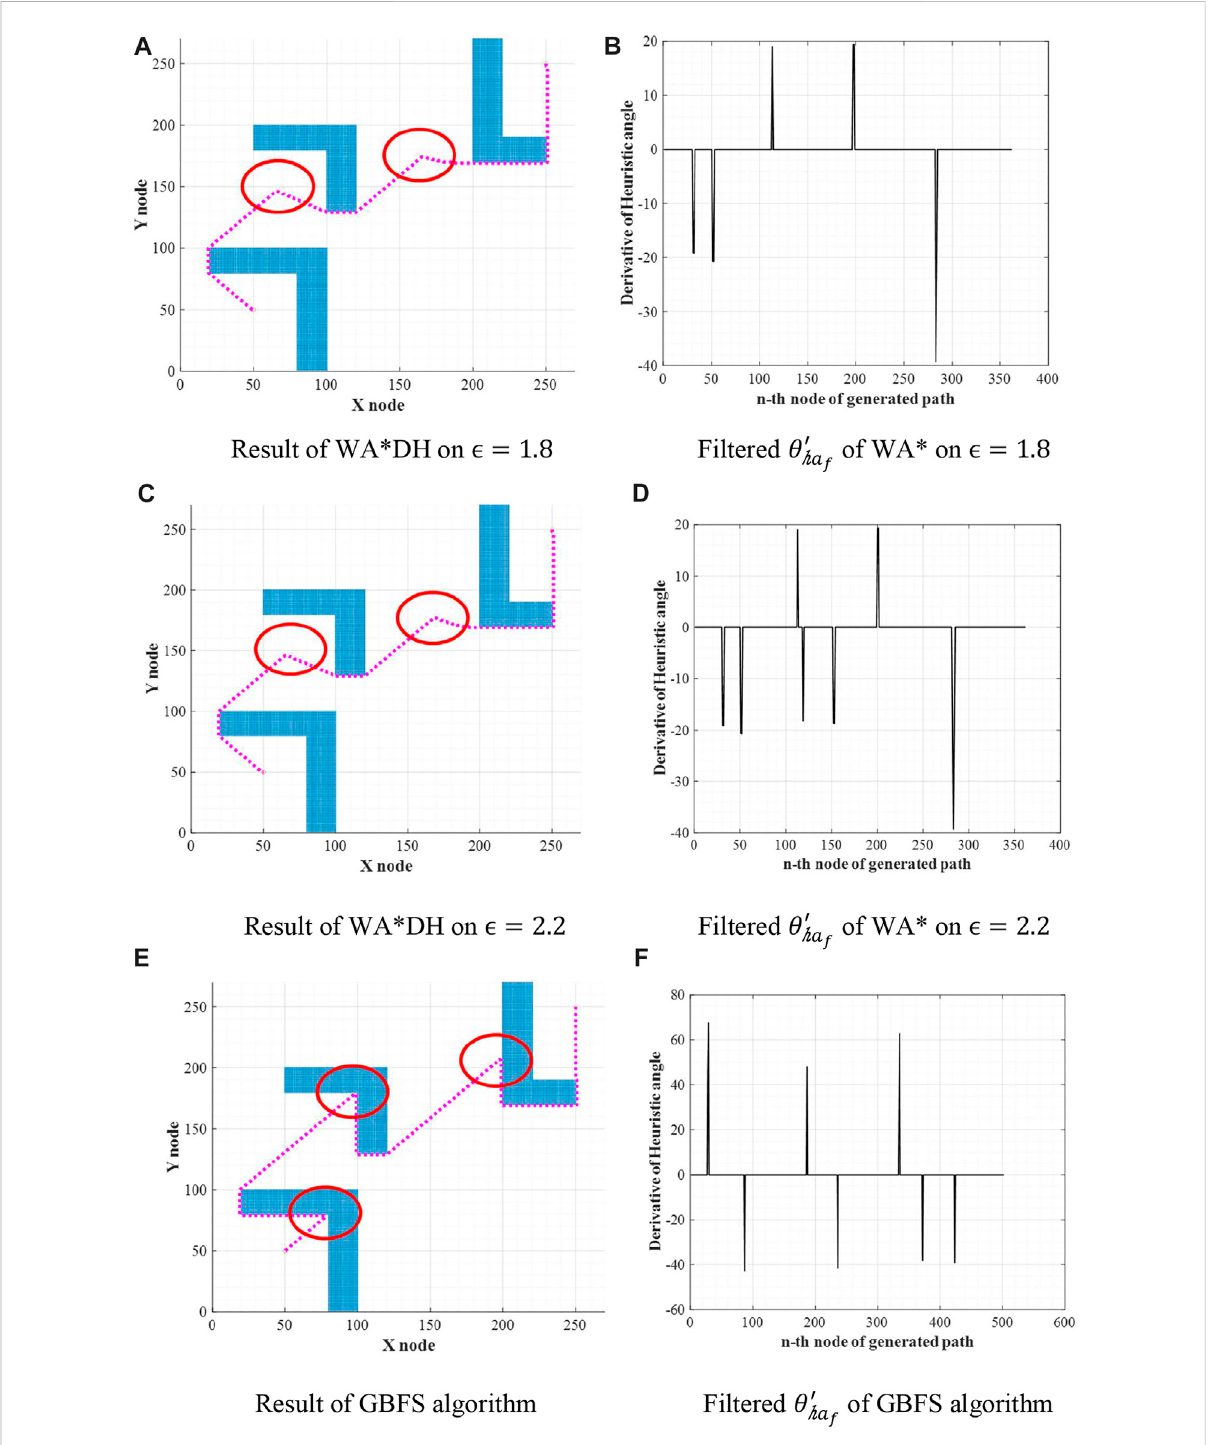
FIGURE 7 Escape nodes of WA* on different in fl ation factors. (A) Result of WA*DH on ϵ (cid:2) 1 . 8. (B) Filtered θ ′ ha f of WA* on ϵ (cid:2) 1 . 8. (C) Result of WA*DH on ϵ (cid:2) 2 . 2. (D) Filtered θ ′ ha ϵ (cid:2) 2 . 2. (E) Result of the GBFS algorithm. (F) Filtered θ ′ ha f of WA* on